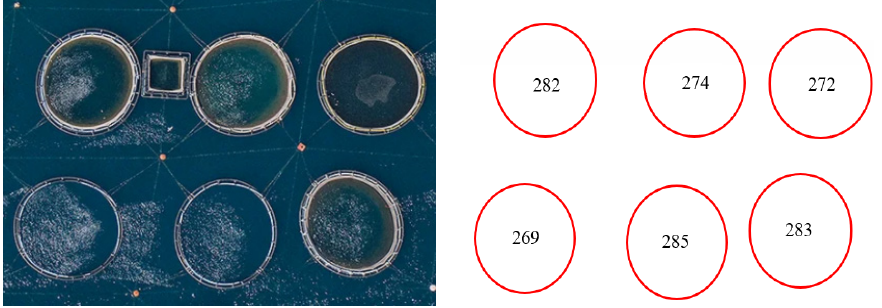
Figure 10. A fish farm satellite image ( Left ) and the extracted circles from the image and radii results ( Right ) using VFCSS algorithm.